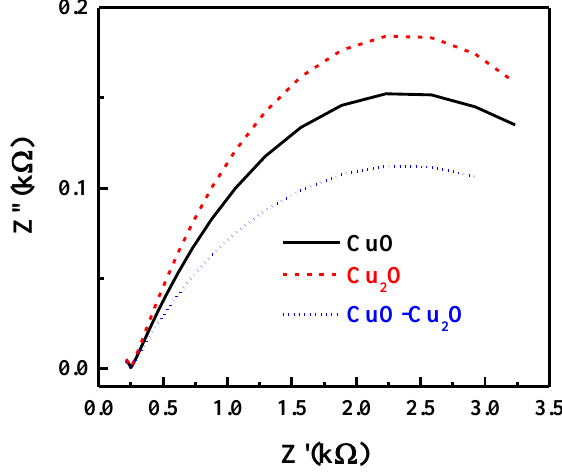
Figure 7. Nyquist plot of the CuO, Cu 2 O and heterojunction CuO – Cu 2 O thin film photocatalysts.